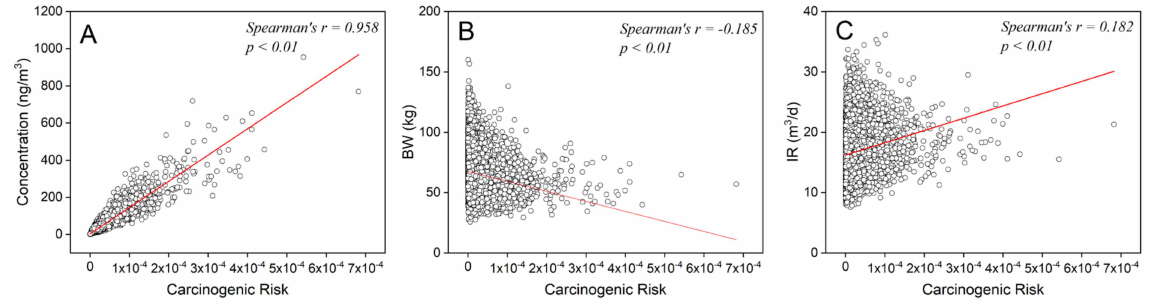
Figure 5. Parameter sensitivity analysis: ( A ) concentration, ( B ) body weight, and ( C ) intake